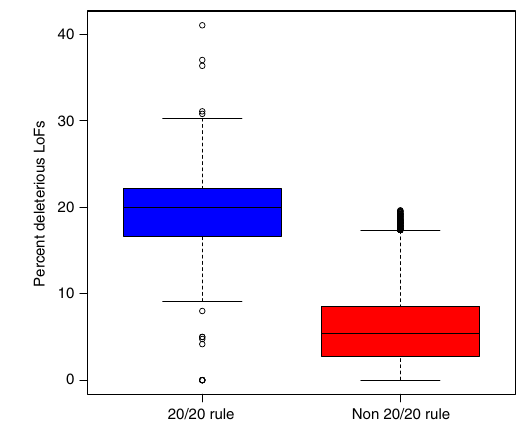
Fig. 6 Proportion of deleterious LoFs in tumor suppressor genes. Tumor suppressor genes were identi fi ed using Vogelstein ’ s 20/20 rule. Samples containing at least 20 somatic mutations were included in this analysis. In the box plots , the center line represents the median value of the data, the box goes from the fi rst quartile to the third quartile. The lower whisker goes from Q1 to the smallest non-outlier in the data set, and the upper whisker goes from Q3 to the largest non-outlier in the data set. Outliers are indicated by the plotted